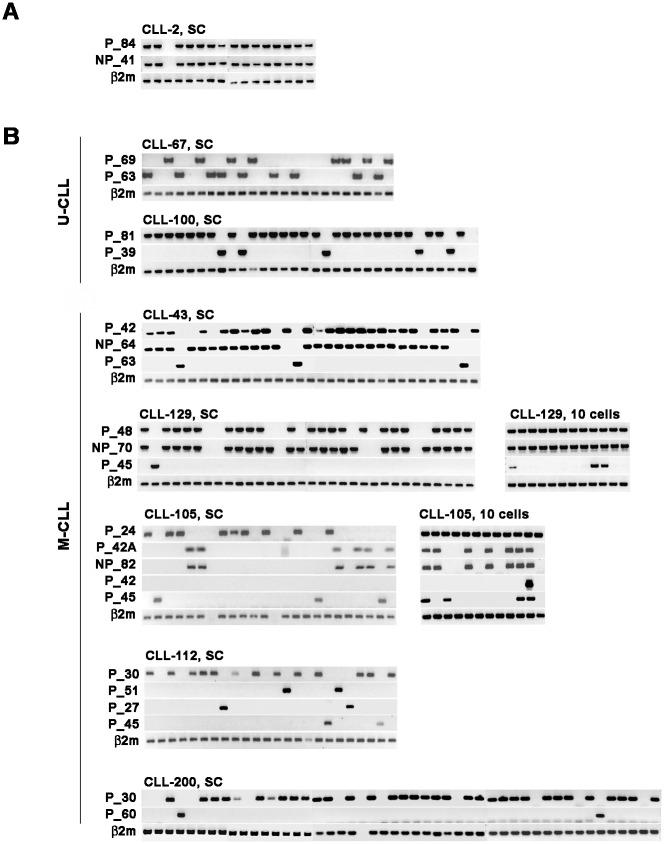
SCA identifies clonal origin of multiple rearranged heavy chain genes.(A) A representative result of biallelic rearrangements derived from single B-cell clone is shown in patient CLL-2. Each column represents nested PCR results of the same single cells. (B) Detection of clonal specific sequences in non-overlapping B-cell populations characterized biclonality or multiple clones (multiclonality). Biclonal or multiclonal B-cells comprised both monoallelic and biallelic clones. The number of single cells analyzed in each patient is larger than the number shown here. Analyses of 10-cell aliquots are shown in CLL-129 and CLL-105 to demonstrate and confirm the existence of clones that were infrequent. SC, single cell.